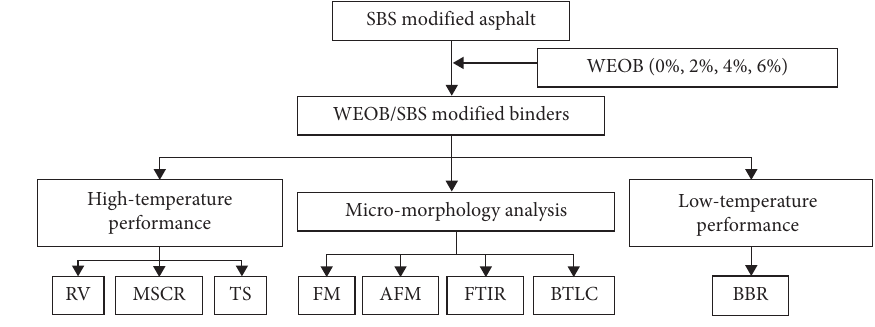
Figure 1: Flowchart of experimental procedure. Table 1: Properties of SBS-modified